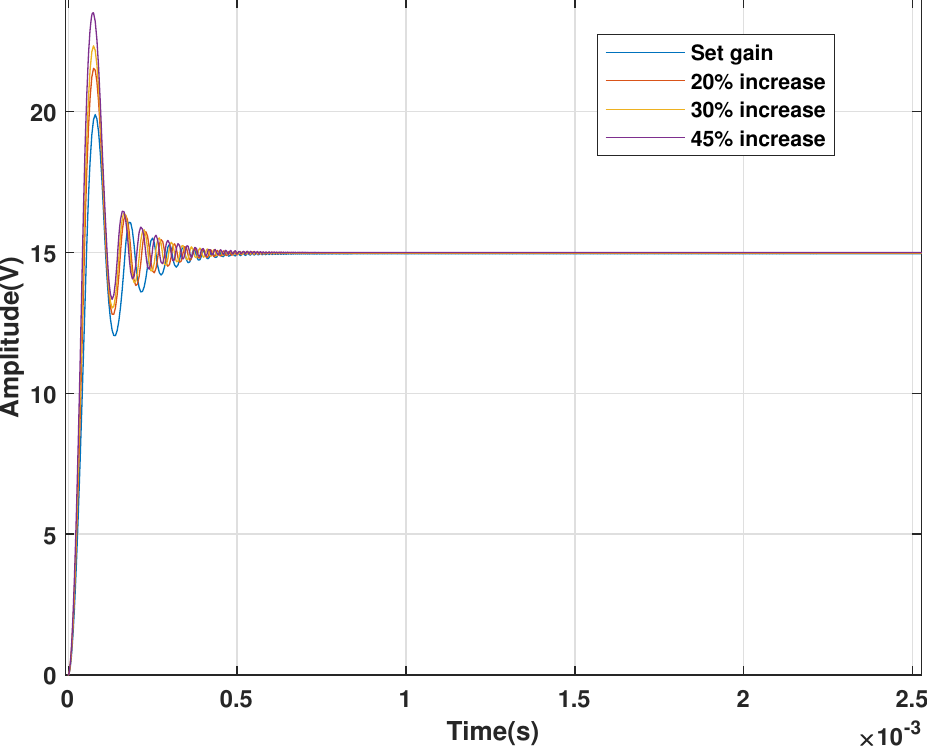
Figure 9. Response of CI optimized PID controller to variation of